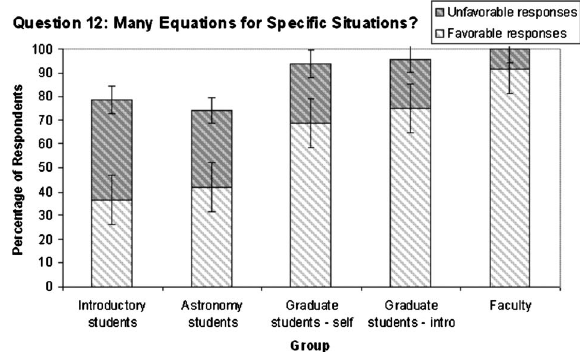
FIG. 9. Histogram showing favorable (cid:1) disagree (cid:2) and unfavor- able (cid:1) agree (cid:2) responses for survey question (cid:1) 12 (cid:2) about whether phys- ics involves many equations each of which applies primarily to a specific situation. As we go from the introductory physics and as- tronomy students to faculty, the disagreement with the statement (cid:1) favorable response